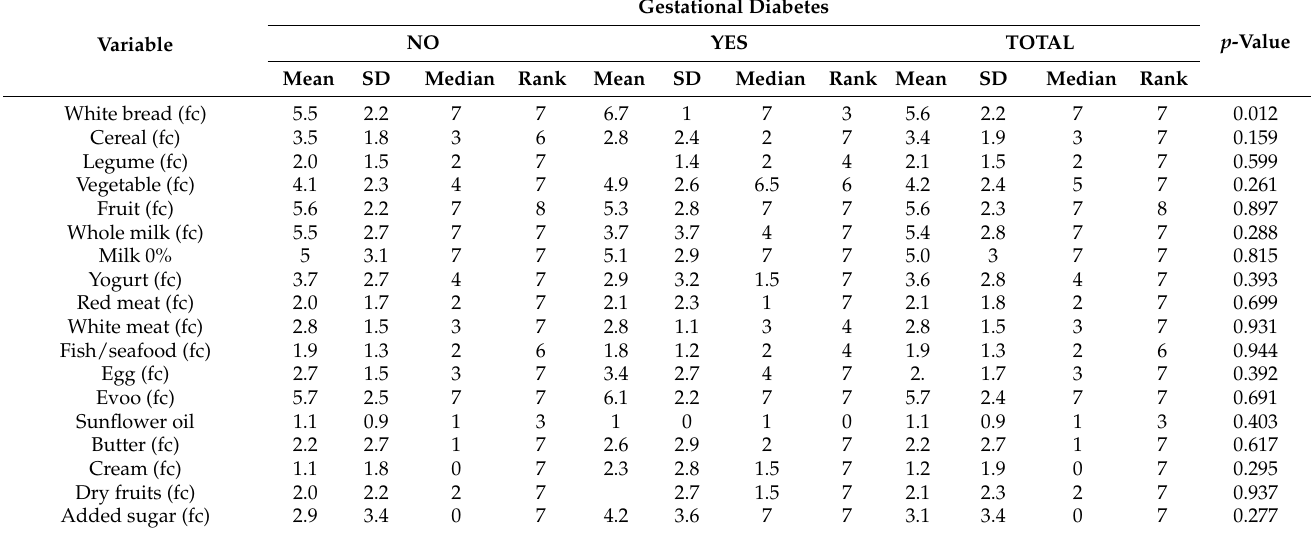
Table 4. Food consumption (shown as weekly frequency, fc) of the pregnant women diagnosed with GDM and those without